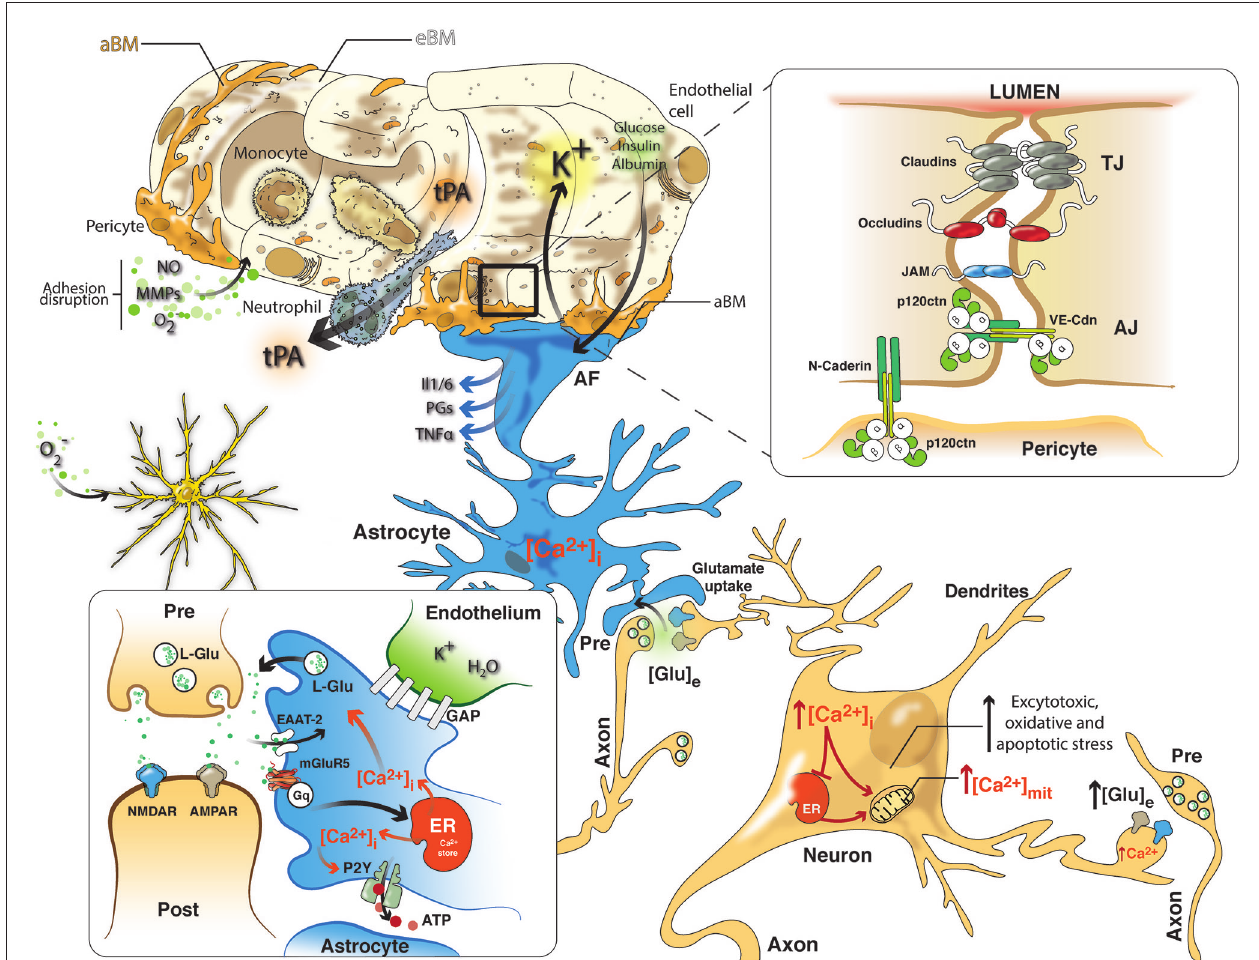
FIGURE 1 | NVU in cerebral ischemia includes a closely coupled signaling network of ECs, pericytes, astrocytes and neurons . Neurovascular uncoupling consists of the expression of various cytokines and adhesion molecules on ECs, promoting leukocyte adherence and accumulation, which thereby initiates an inflammatory response. Further, breakdown of the BBB via NO, MMPs and ROS permits neutrophil extravasation into the ischemic tissue in response to chemokines produced by astrocytes, macrophages, and microglia. Glutamate-mediated excitotoxicity via NMDA and AMPA receptors induces the hyperstimulation of neurons and subsequent calcium influx, indicating several intracellular calcium stores (mitochondria and ER), which triggers dendritotoxic and cell death pathways. Intrinsic neurovascular responses after stroke are triggered by astrocytes via the spread of calcium waves, promoting homeostatic gliotransmission. In addition, glutamate uptake by astrocytes, which requires EAATs, represents the